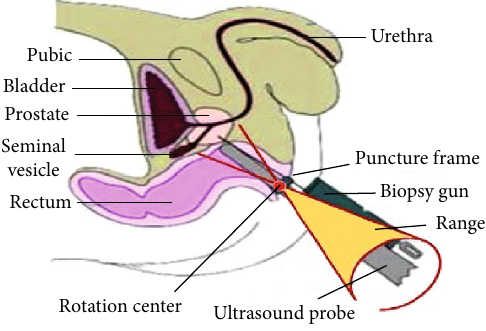
Figure 2: Motion scope of ultrasonic